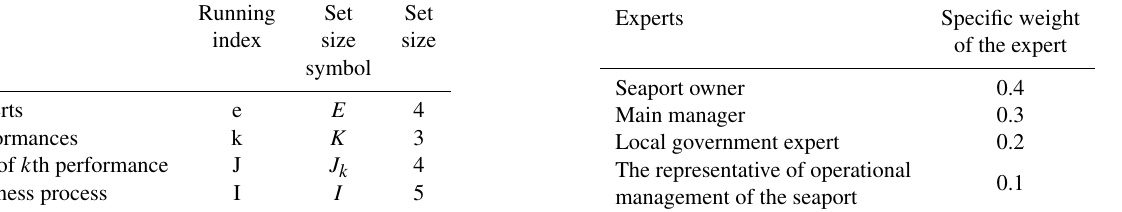
Table 2. Notation. Table 3. Specific weights of expert team.